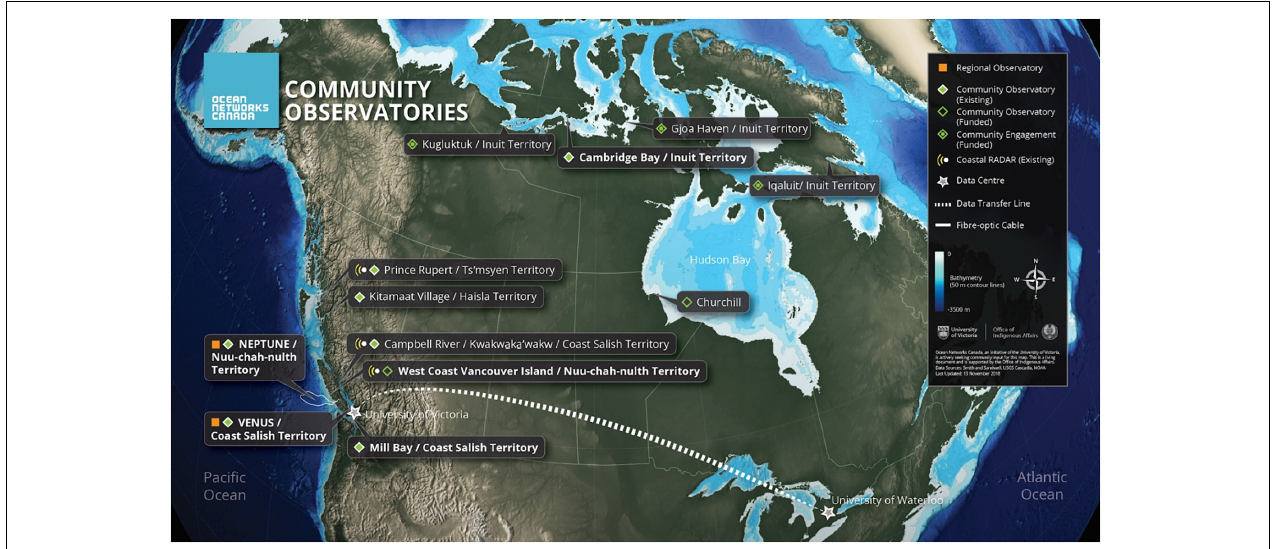
FIGURE 3 | A map of Ocean Networks Canada’s community observatory and community engagement